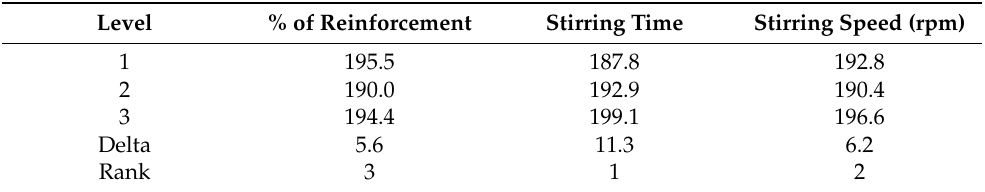
Table 7. Response table for means (ultimate tensile strength).